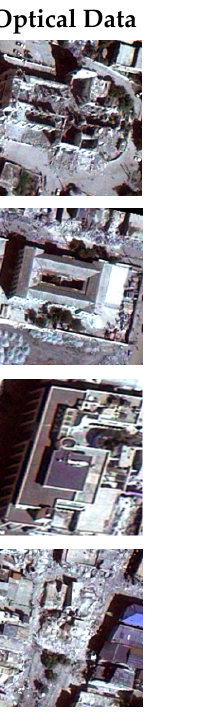
Figure 11. Zoom of some sample buildings in study